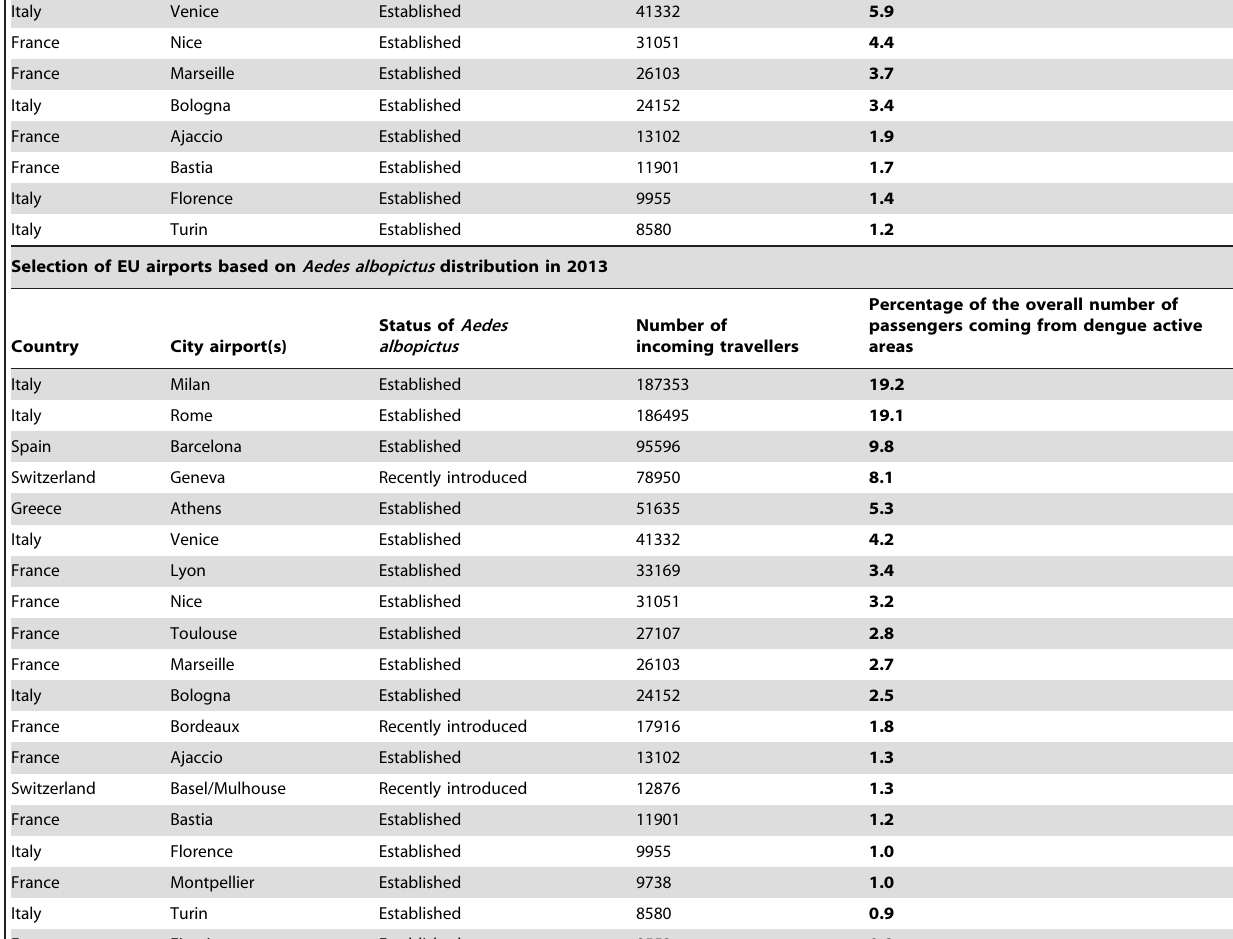
Selection of EU airports based on Aedesalbopictus distribution in 2010